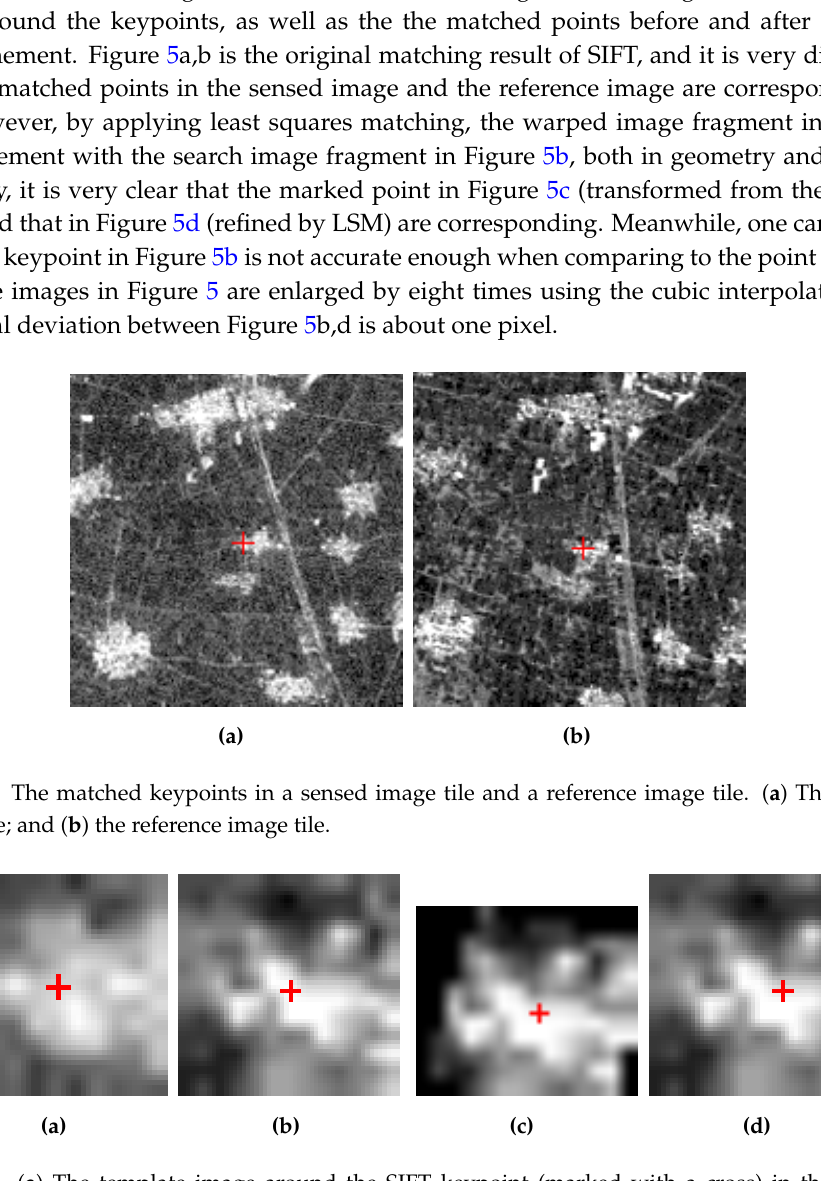
Figure 5. ( a ) The template image around the SIFT keypoint (marked with a cross) in the sensed image tile; ( b ) the search image around the SIFT keypoint (marked with a cross) in the reference image tile; ( c ) an image fragment warped from the template image using the geometric model and the radiometric model in Equation (8), and the cross denotes the SIFT keypoint in the sensed image tile after geometric transformation; ( d ) the search image, and the cross denotes the refined keypoint in the reference image